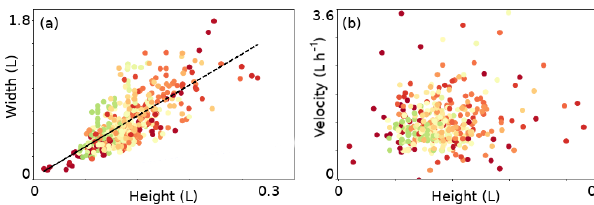
Figure 3. Scaling relationships for dunes observed on 22 October 2018. Length is measured in an arbitrary unit L = 1 ± 0 . 5m. Colors indicate the distance of the dune from the camera (dark red is close, pale green is far), which should be independent of the measured quantities.